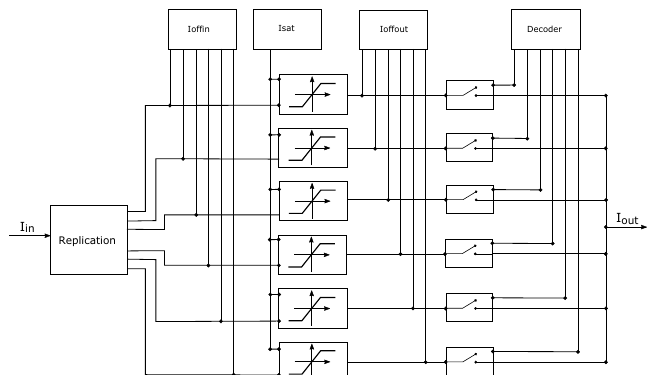
Figure 6. Proposed programmable CMOS current mode PWL function to generate from two to seven scrolls.